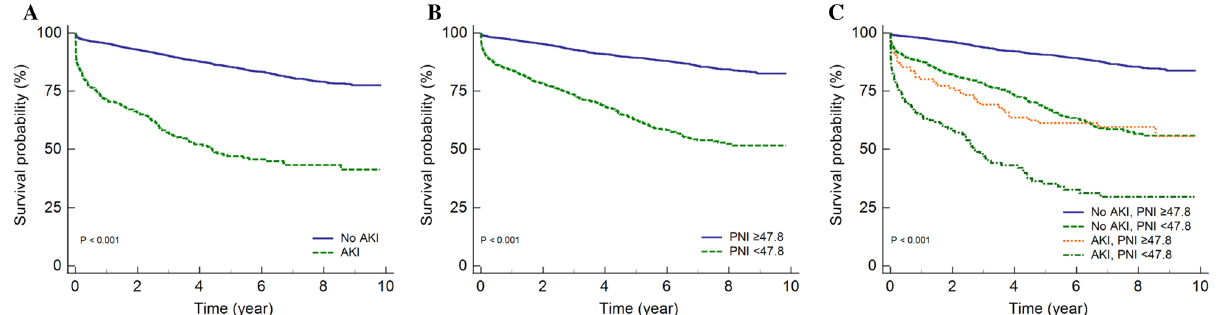
Figure 1. Kaplan–Meier curves for patients’ survival. The survival probability of all-cause mortality in patients ( A ) between patients without AKI and AKI, ( B ) between PNI ≥ 47.8 and PNI < 47.8, ( C ) no AKI/PNI ≥ 47.8, no AKI/PNI < 47.8, AKI/PNI ≥ 47.8, and AKI/PNI < 47.8. PNI, prognostic nutritional index; AKI, acute kidney